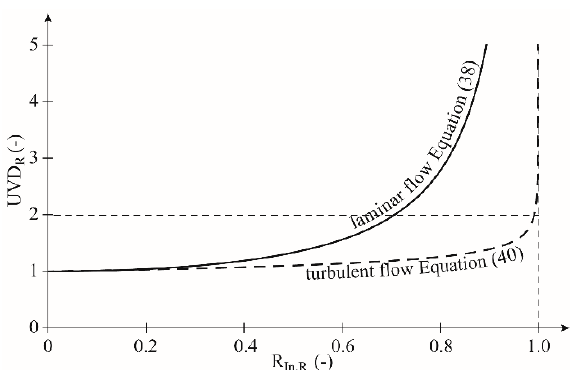
Figure 5. The relation between the relative radiation dose and integral relative radius in the inflow and outflow zones.